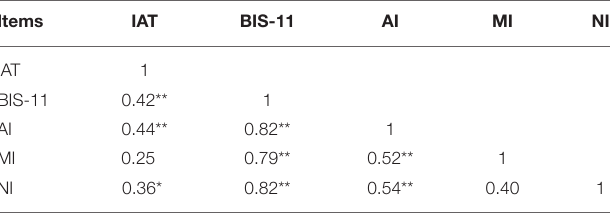
striatal circuits. Compared with the RGU group, the dorsal striatum (caudate, putamen) exhibited significant differences in the directed junction values of the left DLPFC (the coordinate 0.001, cluster level p < 0.05, cluster size = 52). In the RGU group, the dorsal striatum had a positive connection value to the left DLPFC, a one-way positive effect. The activity of the dorsal striatum stimulates the DLPFC. In the IGD group, the connection value was a negative, one-way effect, with dorsal striatum activity inhibiting the left DLPFC ( Figure 1